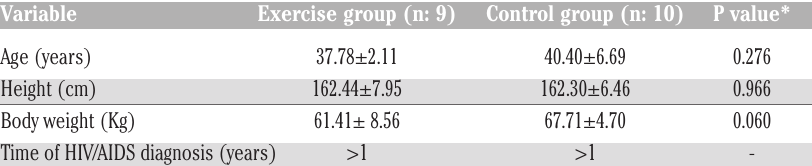
Table 1. Baseline demographic characteristics.